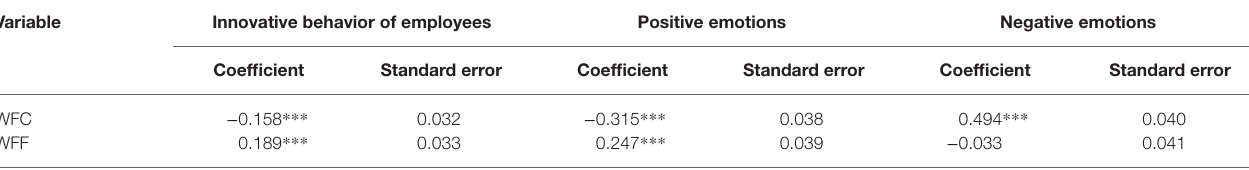
TABLE 4 | Standardized results of the main effects of the work-family status.